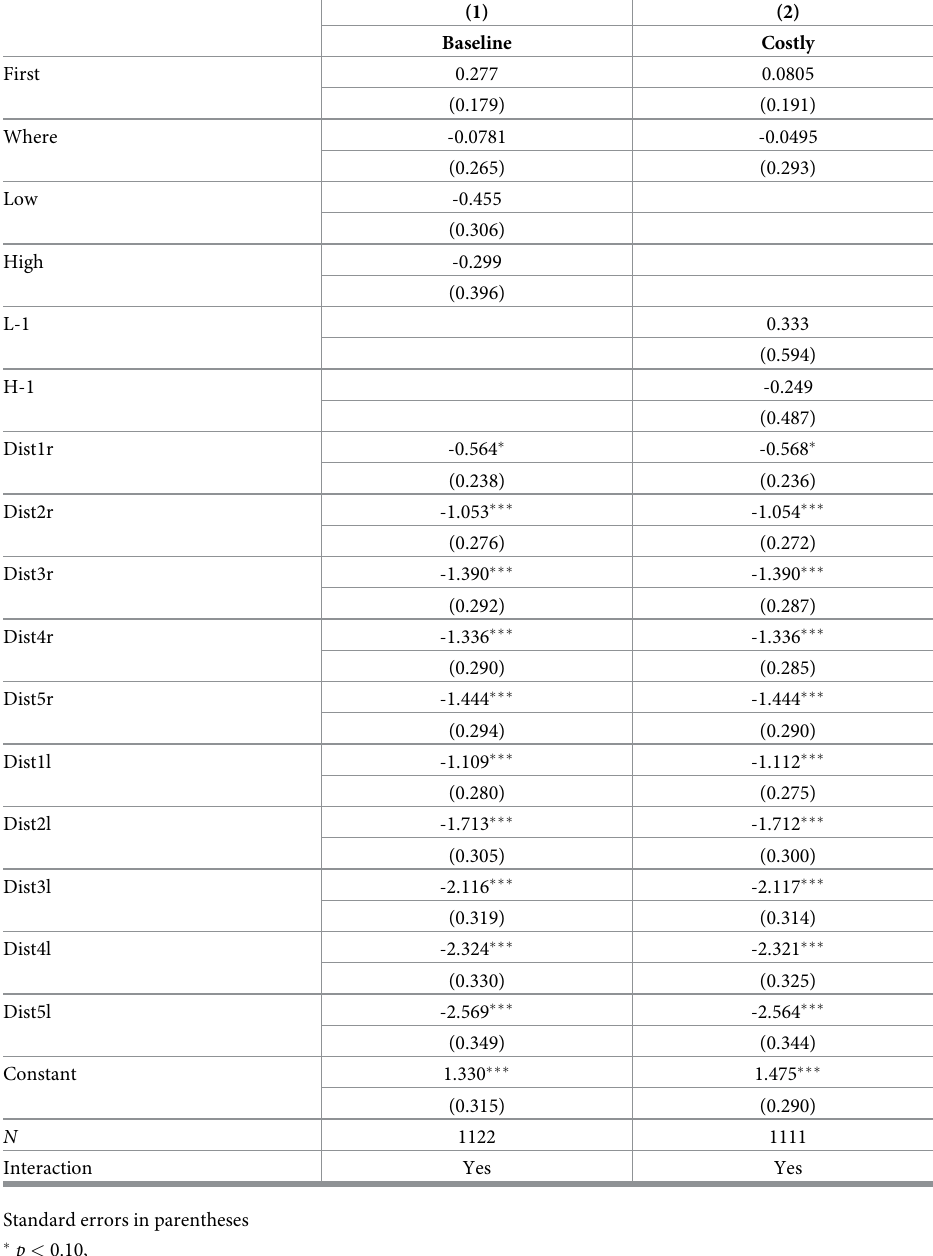
Table 9. Probit model comparing each treatment to baseline N